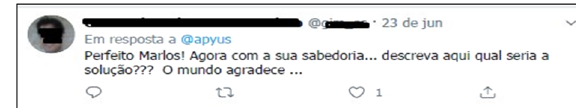
Fig. 8 A Bolsonarian co-framer defying the journalistic discourse. Translation : Perfect Marlos! Now with your wisdom … describe here what would the solution be??? The world thanks you … .